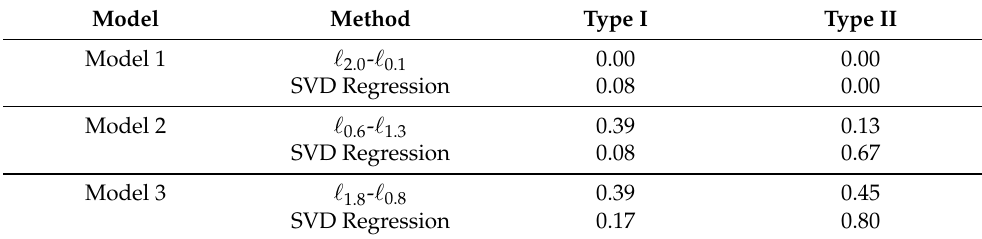
Table 8. Results for 3-circulant SSD.